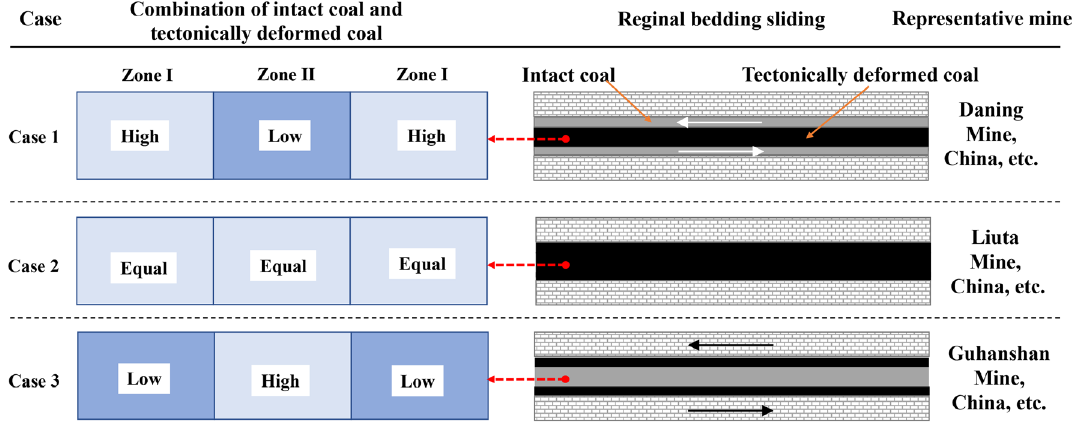
Fig. 1 Typical combination forms of intact-tectonically deformed coal (Zhang et al. 2019; Lu et al. 2019a, b; Geological Report of Guhanshan Mine